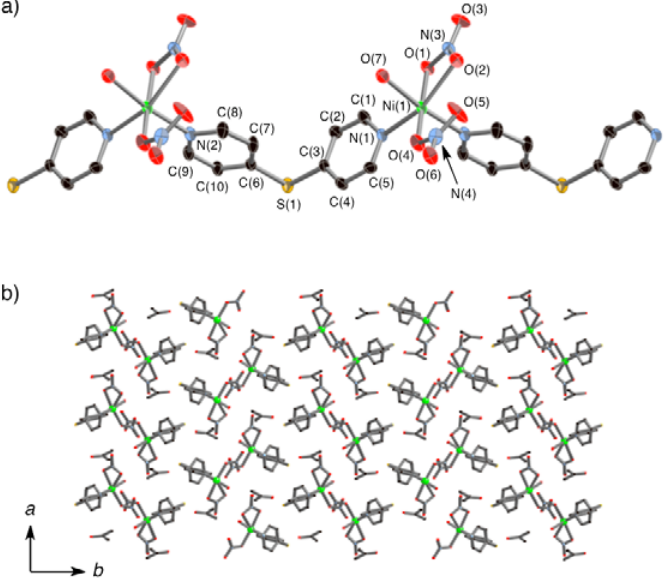
Figure S3. Crystal structure of 4 . The coordination circumstance ( a ) and stacking pattern in the ab plane ( b ).